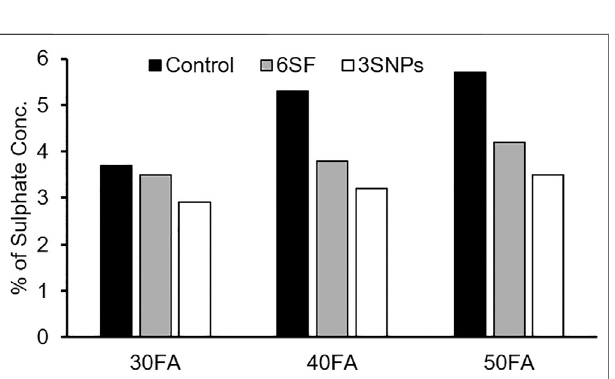
FIGURE 5 | Sulphate ion conc. in fl y ash concrete samples having 3% SNPs and 6% SF with varying the amount fl y ash 30%, 40%, and 50% after 365 days of exposure.